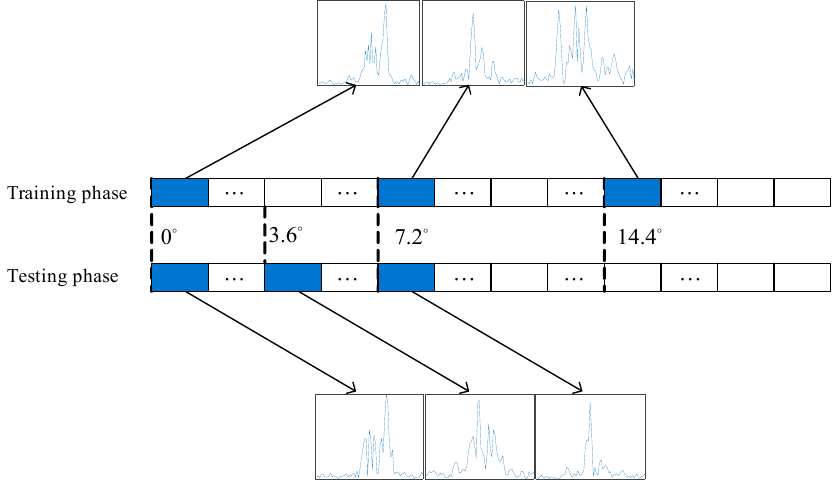
Figure 7. A illustration of the difference of angular sampling intervals between training and testing phase. Where the ratio between testing and training sampling intervals is 1/2.